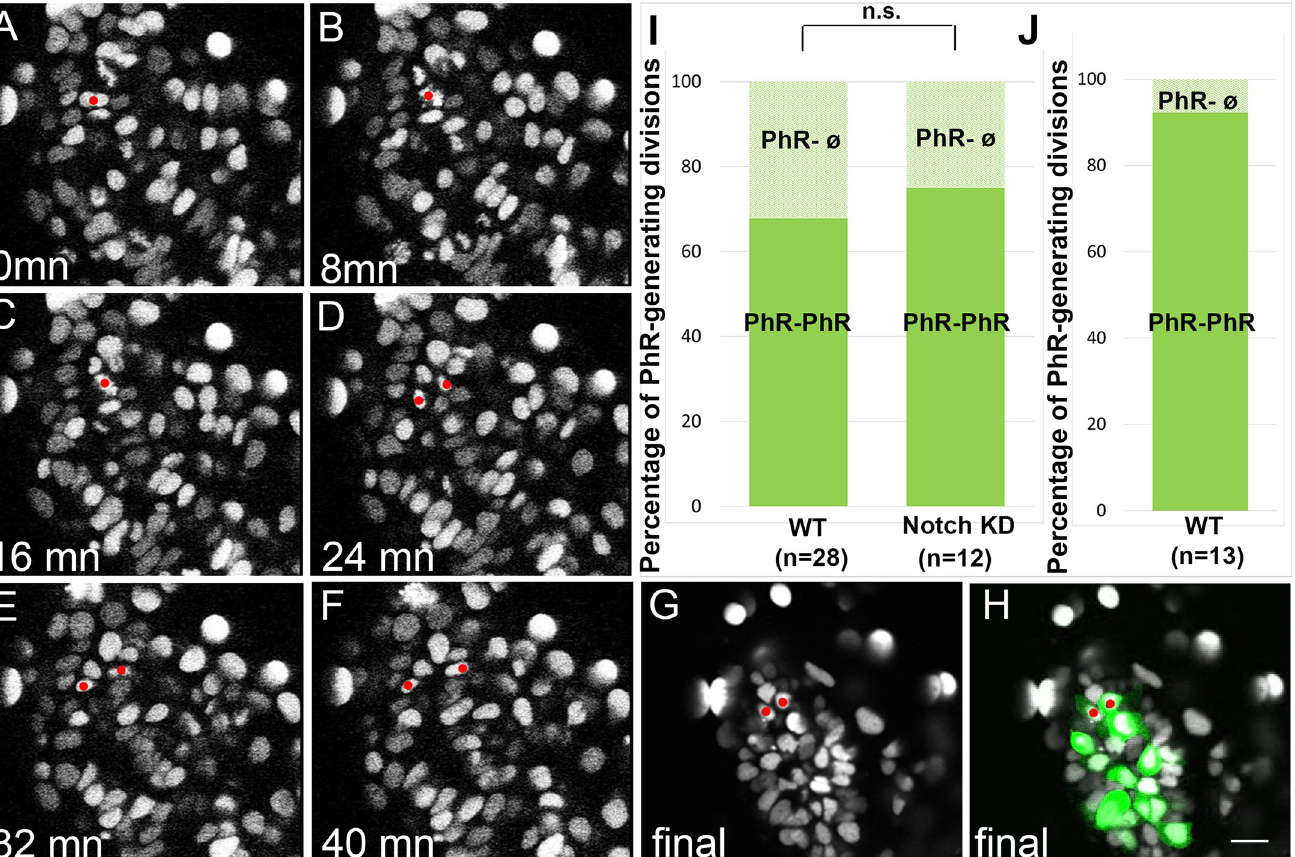
Fig 4. Altering Notch activity does not modify lineage relationships within the pineal. (A-H) Frames from a time-lapse dataset showing an example of a PhR–PhR division. The mother cell (A-C) and the two daughter cells (D-H) are indicated by red dots. Nuclei expressing Histone2B : RFP are shown in gray, and expression of the Tg(aanat2 : gfp) y8 transgene is shown in green. Time is indicated in the lower left corner of each frame, with the first frame arbitrarily set to zero. Anterior is toward the upper right corner. Scale bar represents 10 μ m. (I) Percentage of PhR-generating divisions belonging to the 2-PhR or PhR– ø cell categories in WT and Tg(hsp70l : dnXla . Rbpj-MYC) vu21 (Notch KD) embryos. No difference was observed between the Tg(hsp70l : dnXla . Rbpj-MYC) vu21 and WT embryos using a chi-squared test (n. s.). n indicates the number of successfully tracked cells. Thirteen and 4 embryos were used for the tracking of cells in the WT and Notch-impaired contexts, respectively. In this set of experiments, the embryos reach a final stage of 33–35 hpf. (J) Percentage of PhR-generating divisions belonging to the 2-PhR or PhR– ø cell categories in WT embryos after long acquisitions. In this set of experiments, the embryos reach a final stage of 46 hpf. n indicates the number of successfully tracked cells from 7 embryos. Scale bar represents 10 μ m. Underlying data can be found in S1 Data. hpf, hours post fertilization; KD, knock-down; n.s., not significant; PhR, photoreceptor; WT, wild type.